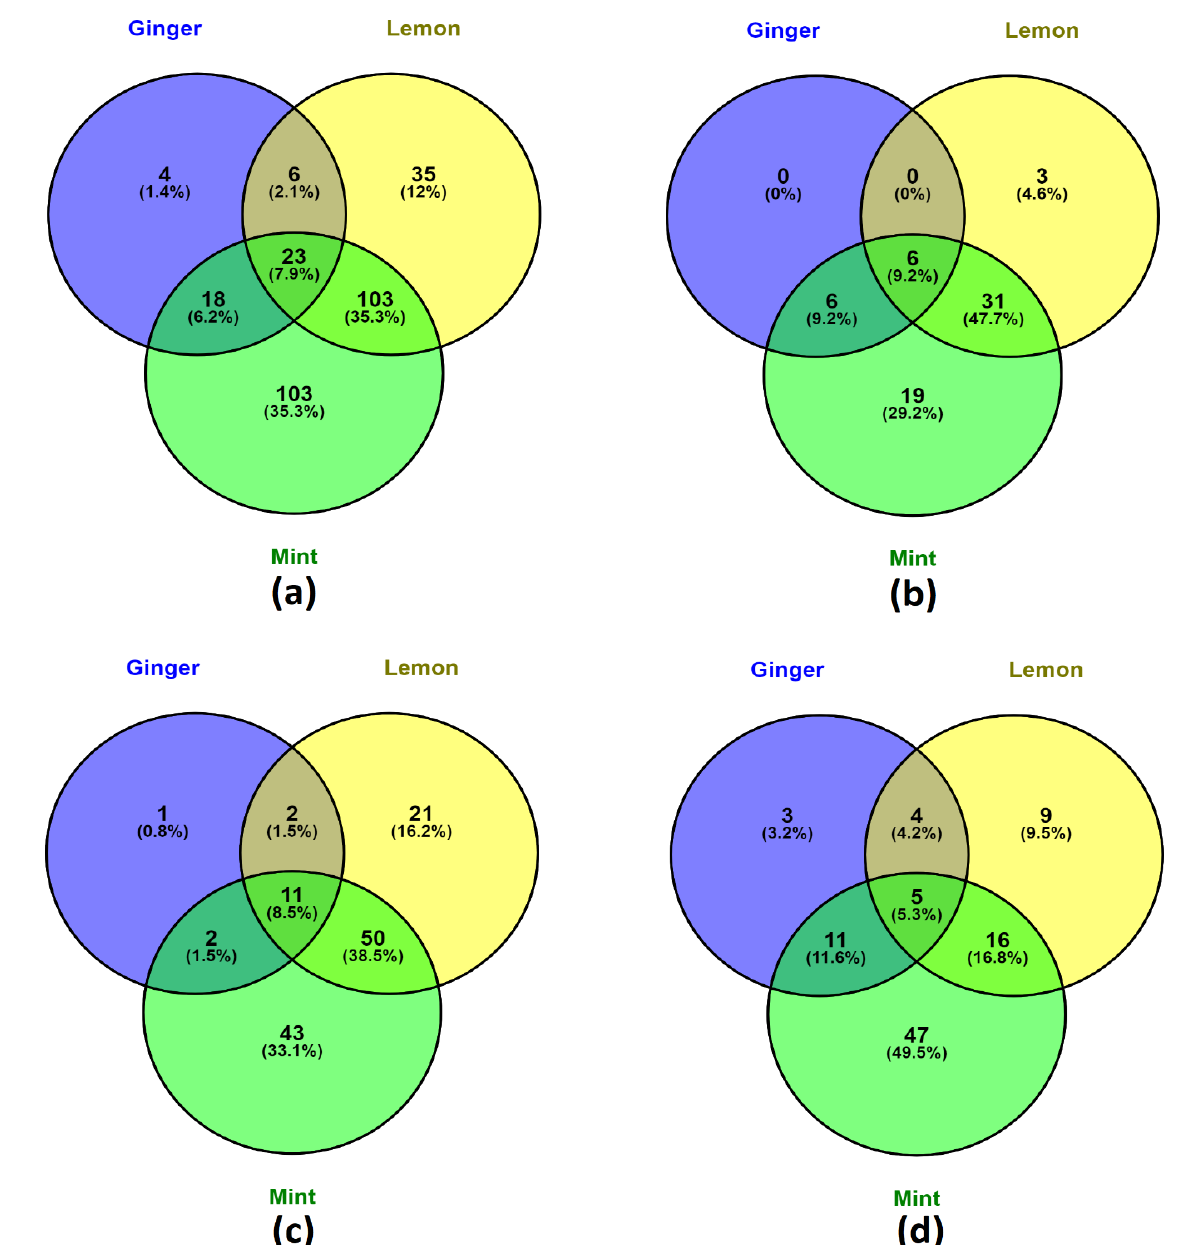
Figure 1. Venn Diagram of the distribution of screened phenolic compounds. ( a ) Total phenolic compounds found in ginger, lemon and mint; ( b ) Phenolic acids in ginger, lemon and mint; ( c ) Flavonoids in ginger, lemon and mint; ( d ) Other polyphenols (including lignans and stilbenes) in ginger, lemon and mint.